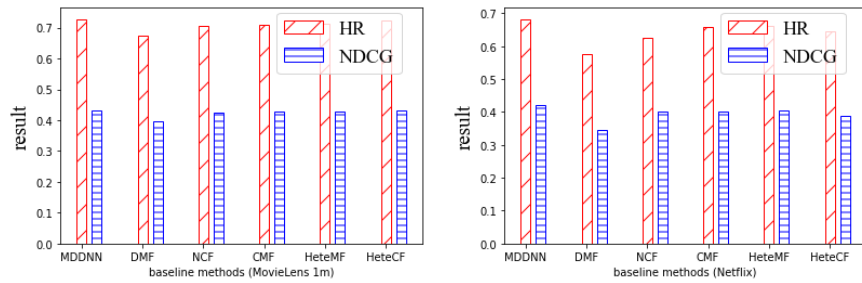
Figure 17. The results of the MFDNN and baseline